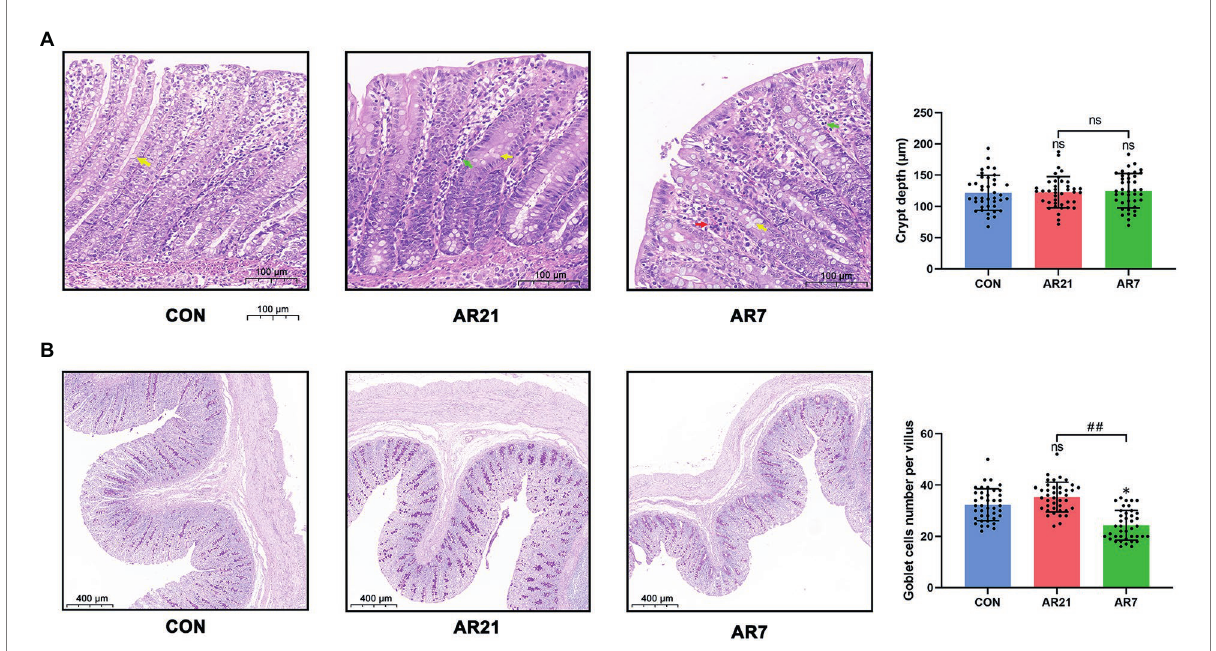
FIGURE 4 Effects of artificial rearing on the histology in piglet colon. (A) Microstructure of piglet colon (H&E staining). Yellow arrow indicates vacuoles. Green arrow indicates leukocyte infiltration. Red arrow indicates red blood cell infiltration. (B) Mean number of goblet cells (PAS staining). Data are presented with mean ± SD. ns p > 0.05; * p < 0.05 versus the CON group; ## p < 0.01 versus the AR21 group. n = 8 piglets.